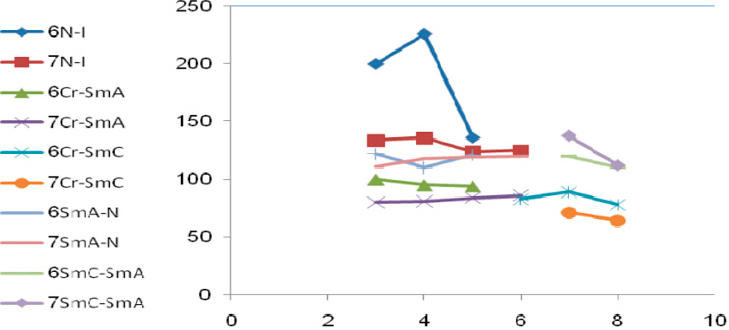
Figure 5. Graph of transition temperature against the number of carbon atoms. Reprinted/adapted with permission from Ref. [34]; published by JIARM, 2014.